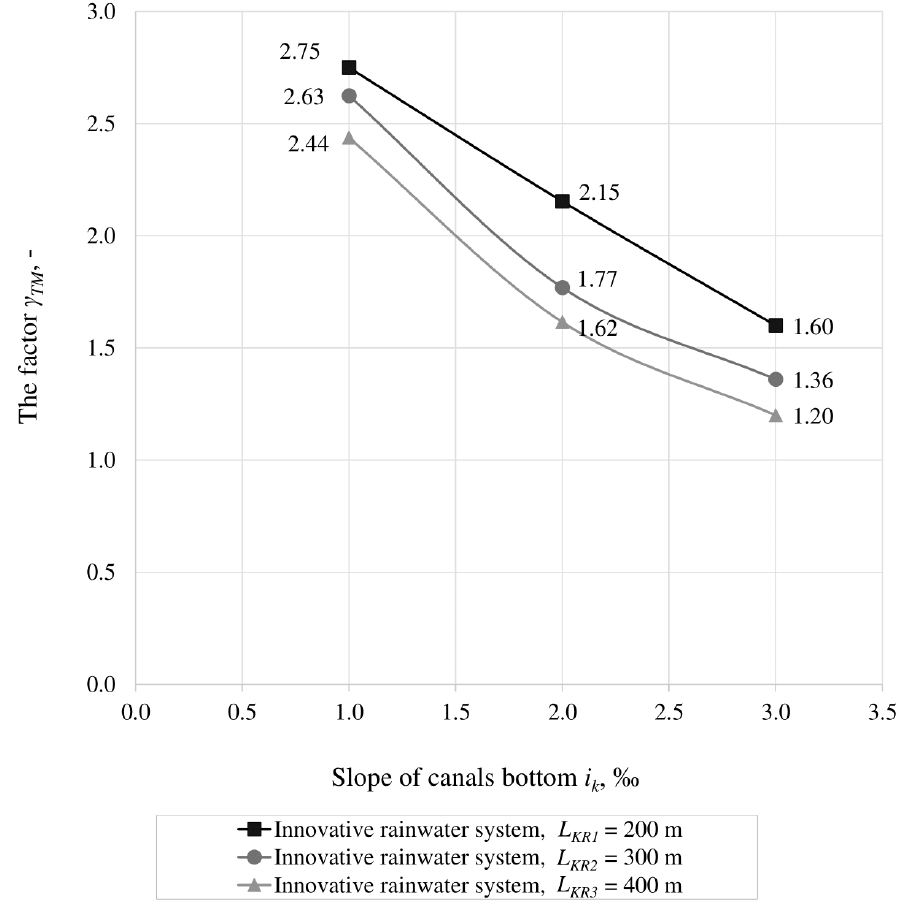
depending on the sewer slope i TM